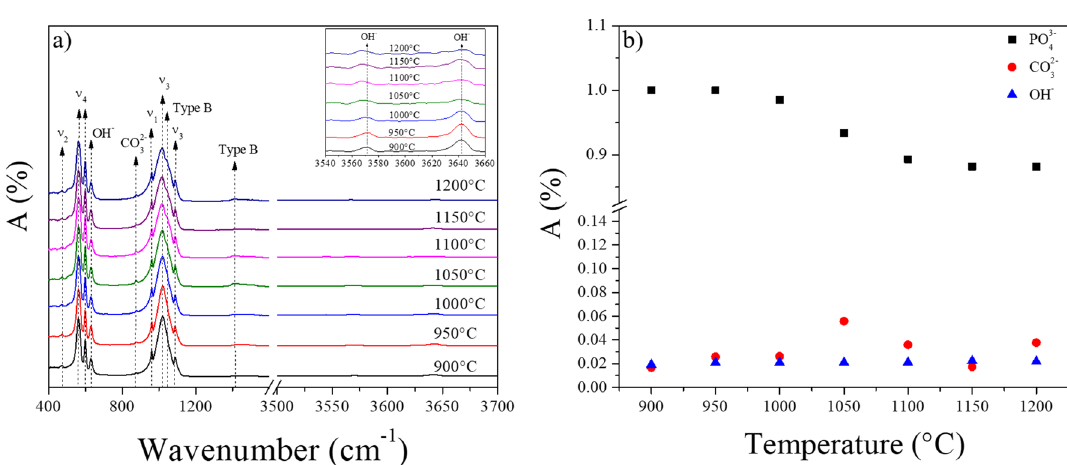
Figure 3. ( a ) FT-IR spectra of the samples treated at different calcination temperatures. ( b ) Intensities of the normalized functional groups as a function of the calcination